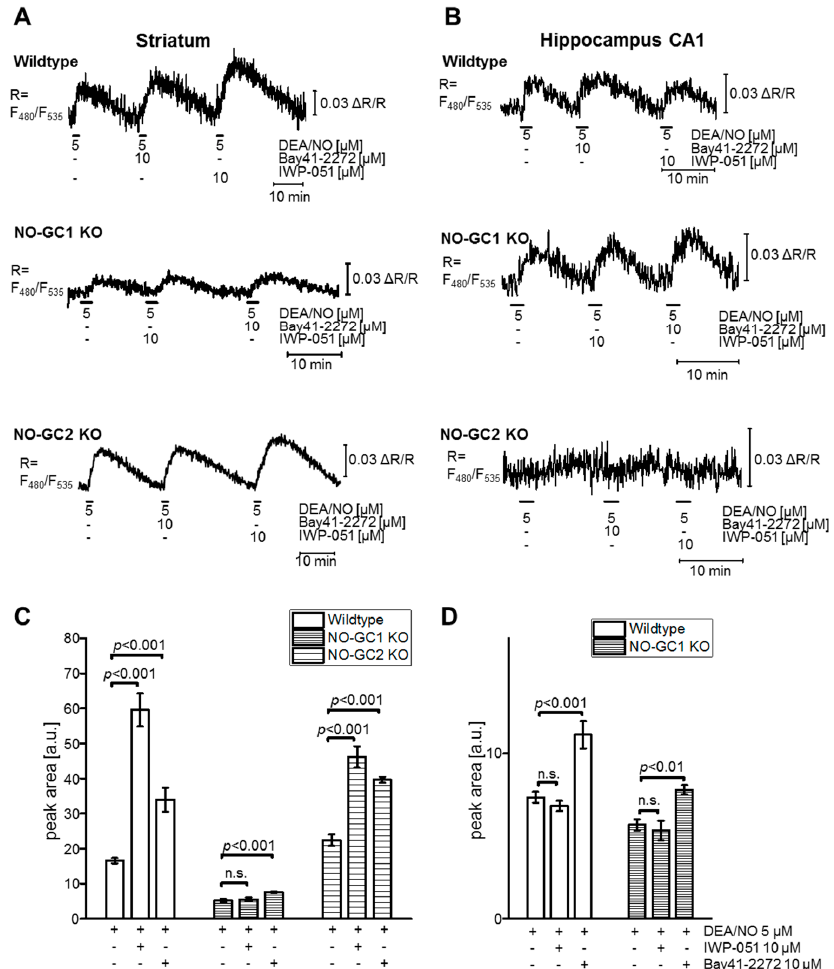
Figure 6. cGMP imaging in acute brain slices of NO-GC1 and NO-GC2 knockout mice reveals different activities of IWP-051 and Bay 41-2272 in ( A , C ) striatum and ( B , D ) hippocampus. Representative cGMP measurements (showing CFP/YFP ratios) performed ( A ) in the striatum and ( B ) hippocampus of wildtype, NO-GC1 KO and NO-GC2 KO mice that had been crossed to NesCre;R26-CAG-cGi500(L2) mice and, thus, expressed cGi500 in neurons and glia cells. DEA/NO, IWP-051, and Bay 41-2272 were applied in the indicated concentrations (black horizontal lines). Statistical analysis of respective cGMP signals in ( C ) striatum (wildtype, n = 22; NO-GC1 KO, n = 16; NO-GC2 KO, n = 16) and ( D ) hippocampus (wildtype, n = 22; NO-GC1 KO, n = 9) was performed with peak areas; data are shown as mean ± SEM ( n -numbers represent number of evaluated ROIs from at least three brain slices per genotype); n.s., not significant. To avoid false-positive signals, only ROIs that were separated from surrounding blood vessels were analyzed. Note that the absence of detectable cGMP signals in the hippocampus of NO-GC2 KO precluded statistical analysis. For each genotype and brain region, similar results were obtained in independent experiments with brain slices from three mice.